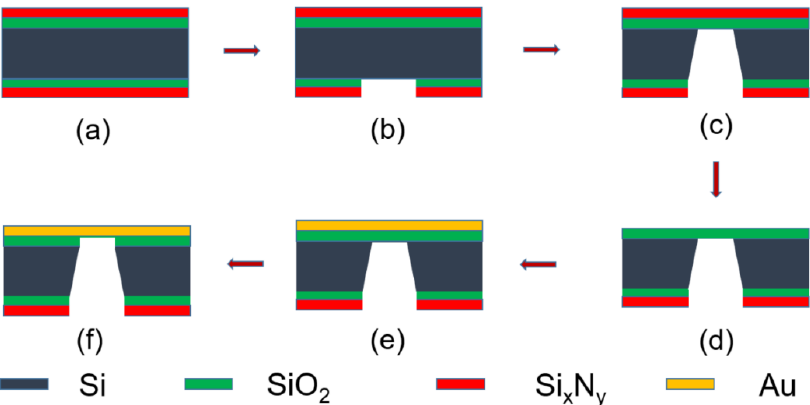
Figure 5. MEMS process diagram of the suspended gold film. ( a ) LPCVD for silicon dioxide and silicon nitride layer on both sides separately, ( b ) Lithography and RIE to expose square windows on the backside, ( c ) Wet etching to remove exposed silicon substrate using KOH solution, ( d ) RIE to remove all the silicon nitride layer on the front side, ( e ) Gold film deposition of 120 nm using PVD process, and ( f ) Release-etching of silicon dioxide layer to complete the process with BHF